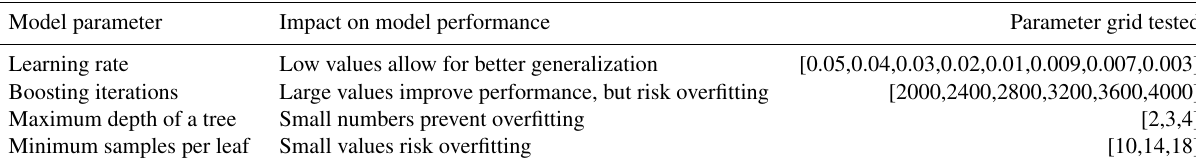
Table 1. Model parameter grid tested during 3-fold